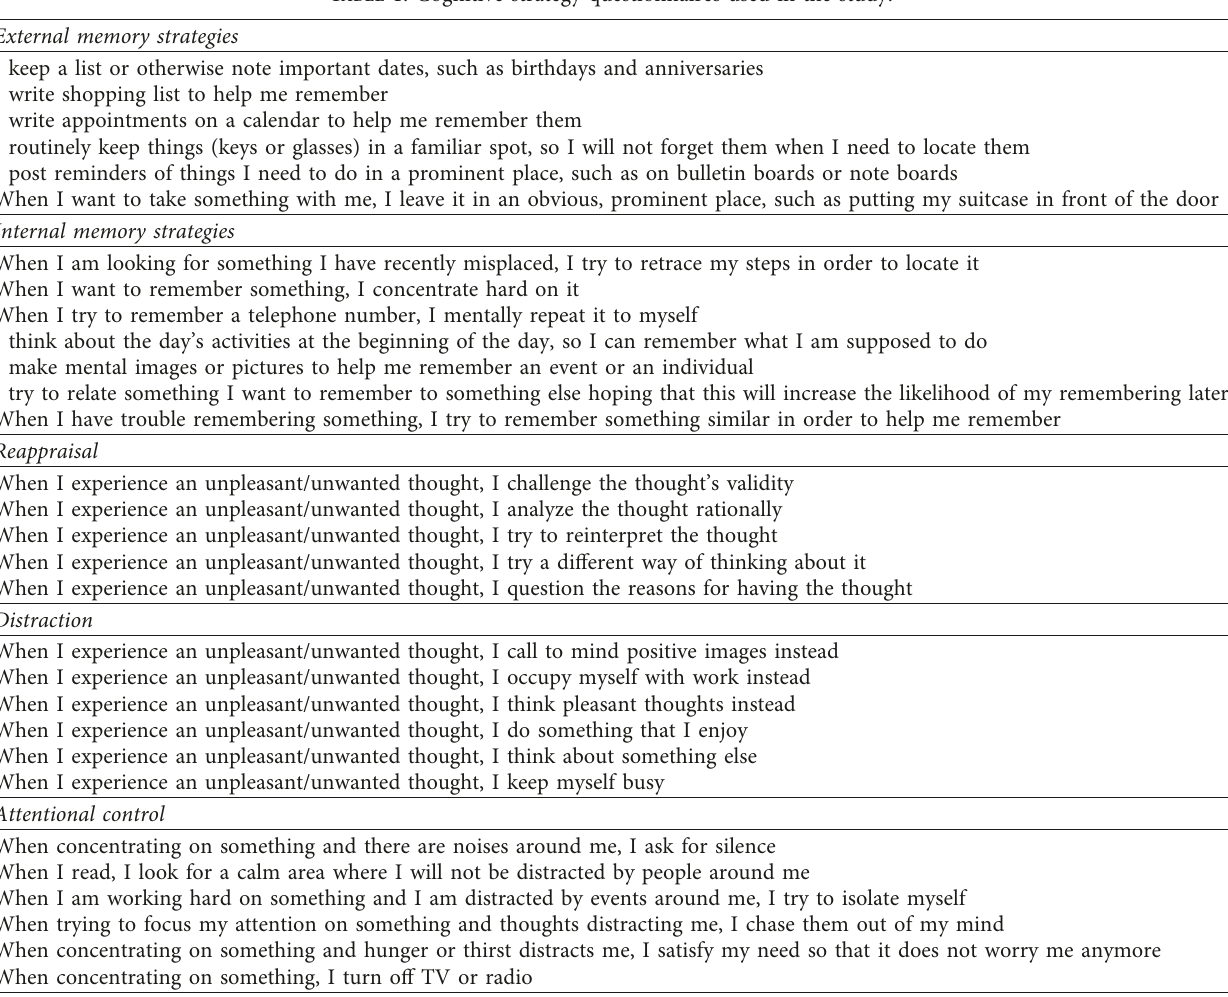
Table 1: Cognitive strategy questionnaires used in the